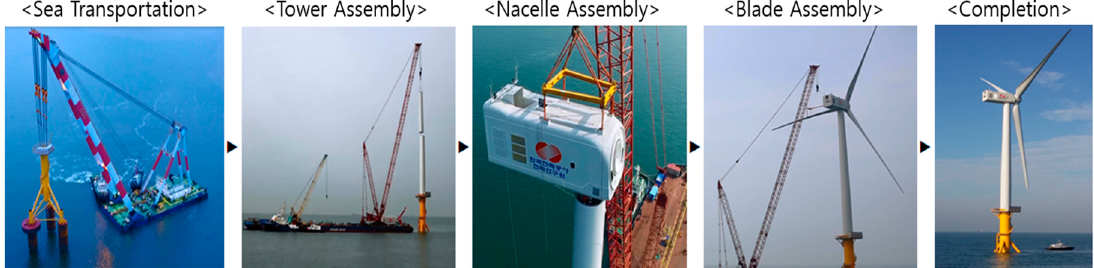
Figure 18. Installation process of suction bucket offshore wind turbine.